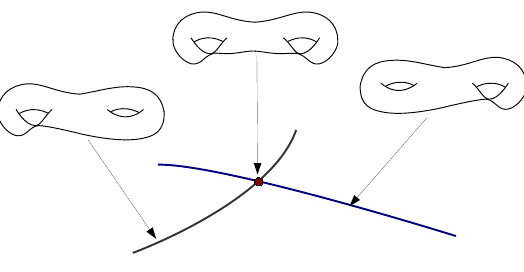
Figure 5 . Two normally intersecting divisors of the discriminant locus (cid:1). The singularity of the Calabi-Yau threefold, here depicted as genus-two Riemann surface, worsens at the intersection. divisor (cid:1) corresponding to singular Calabi-Yau manifolds it can be embedded into a s projective space. The discriminant locus (cid:1) can have a very non-trivial structure, since s